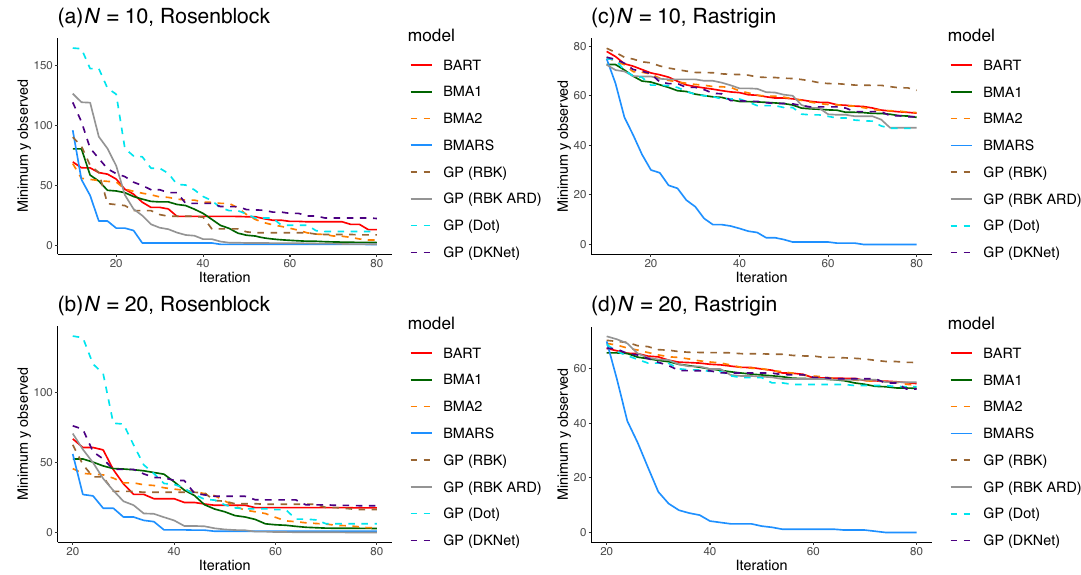
Fig. 2 The average minimum y observed based on each model in each iteration. a Rosenbrock function with the initial set of sample size N = 10. b Rosenbrock function with the initial set of sample size N = 20. c Rastrigin function with the initial set of sample size N = 10. d Rastrigin function with the initial set of sample size N =